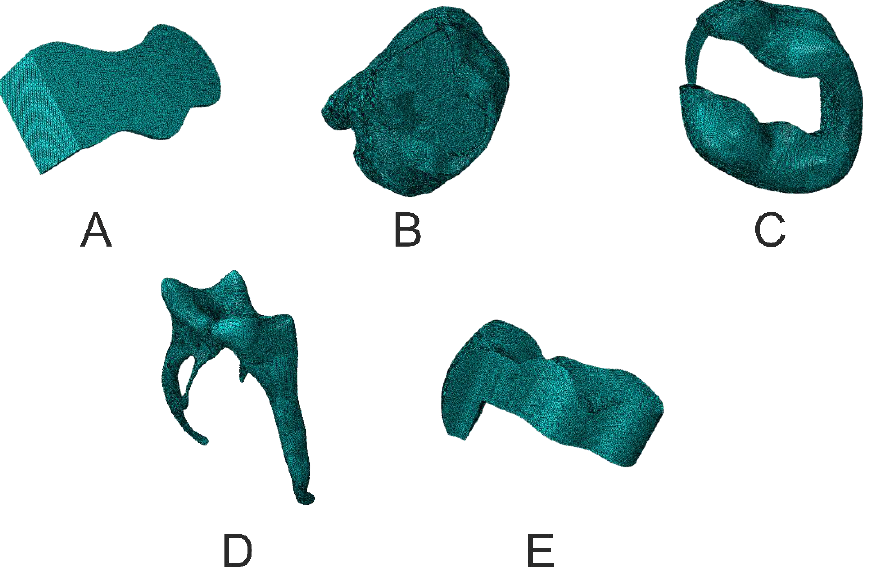
Figure 2. Three-dimensional tooth model structures (( A ): cement, ( B ): dentin, ( C ): enamel, ( D ): pulp, ( E ): restoration).